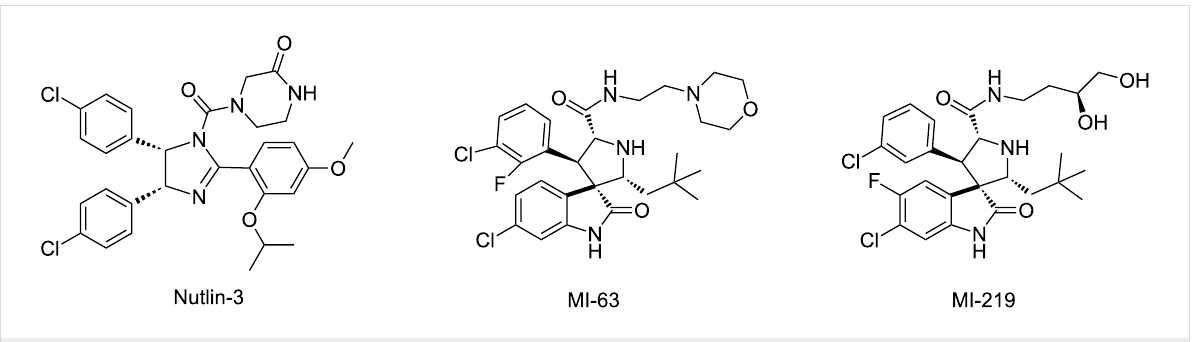
Figure 1: Some relevant MDM2-p53 interaction inhibitors.